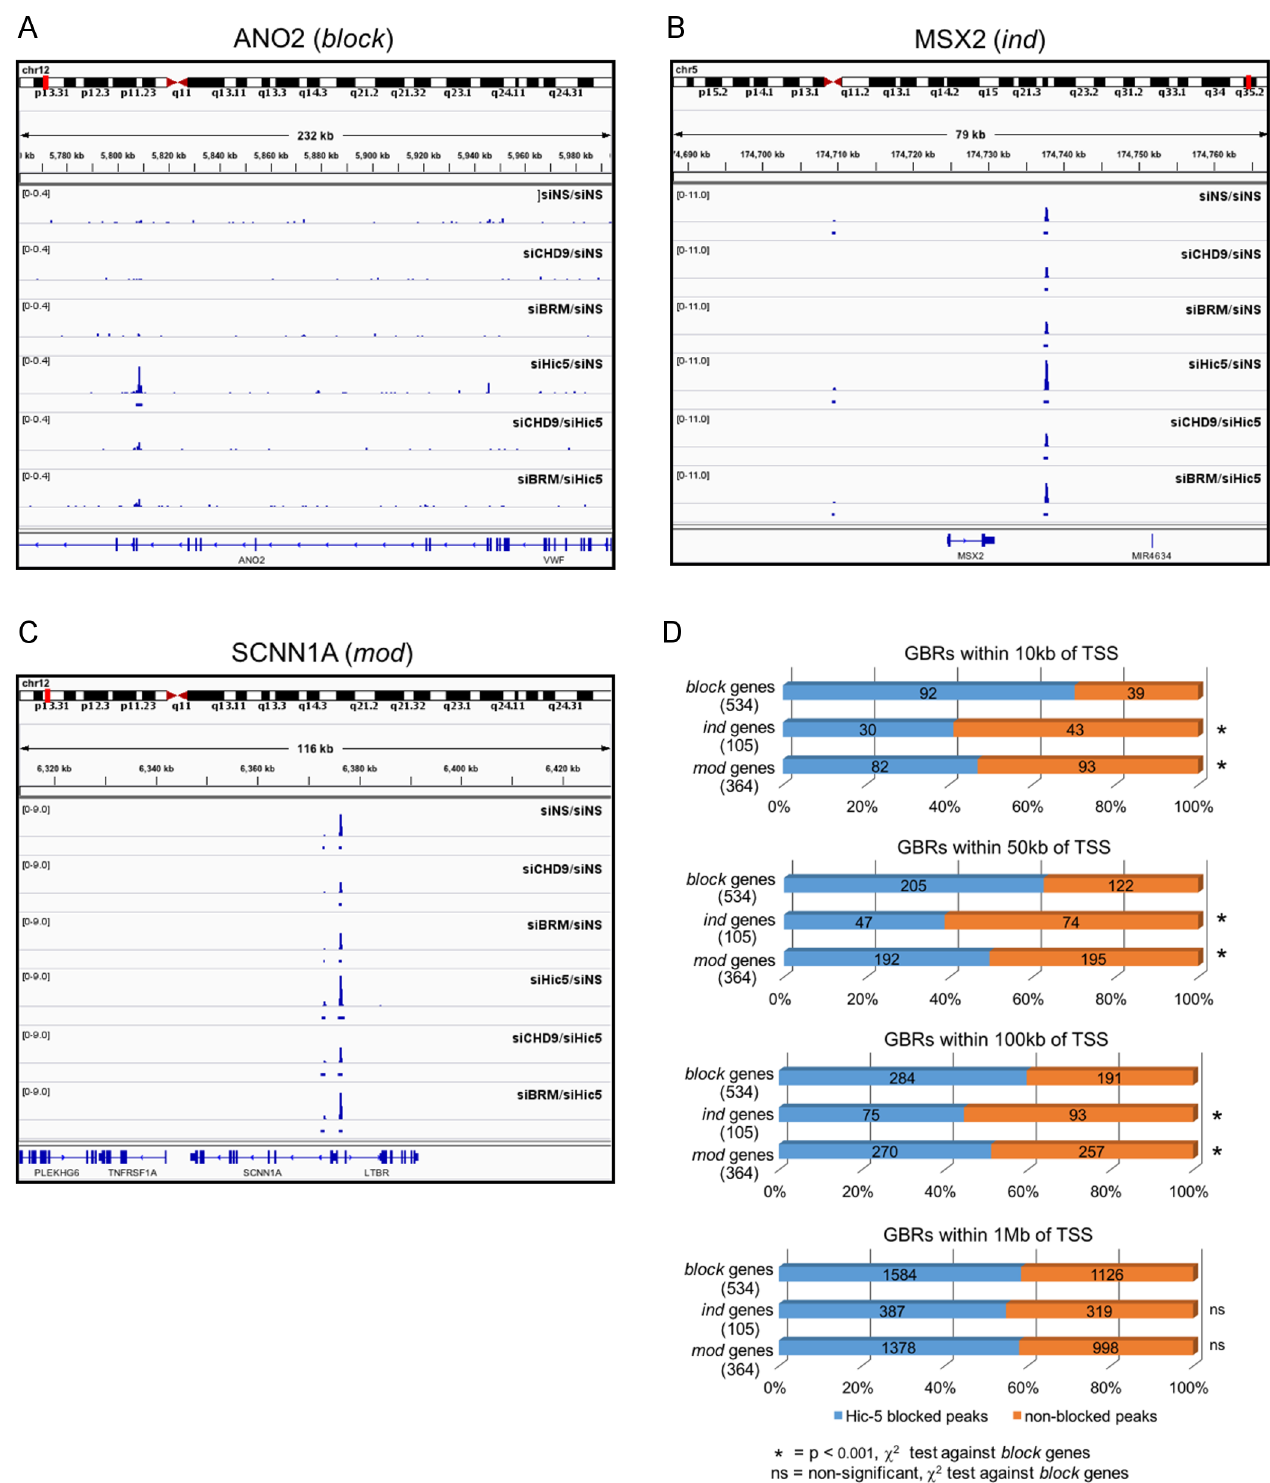
Fig 3. Hic-5 blocked GBR are preferentially enriched near the block genes. A-C) Integrative Genomics Viewer displaying the ChIP-seq track of GR occupancy near block gene ANO2 (A), ind gene MSX2 (B), and mod gene SCNN1A (C). D) Proportion of Hic-5 blocked GBR and non-blocked GBR within 10 kb, 50 kb, 100 kb and 1 Mb of TSS for all genes in each of the three gene classes. Blue bars represent the proportion of Hic-5 blocked GBR; orange bars represent the proportion of non-blocked GBR; the total number of GBR is indicated on each bar. χ 2 test was performed to compare the ratio of blocked and non-blocked GBR near the ind genes and mod genes with the ratio of blocked and non-blocked GBR near the block genes. ( (cid:3) = p < 0.001, ns = not significant). https://doi.org/10.1371/journal.pone.0196965.g003 PLOS ONE | https://doi.org/10.1371/journal.pone.0196965 May 8,